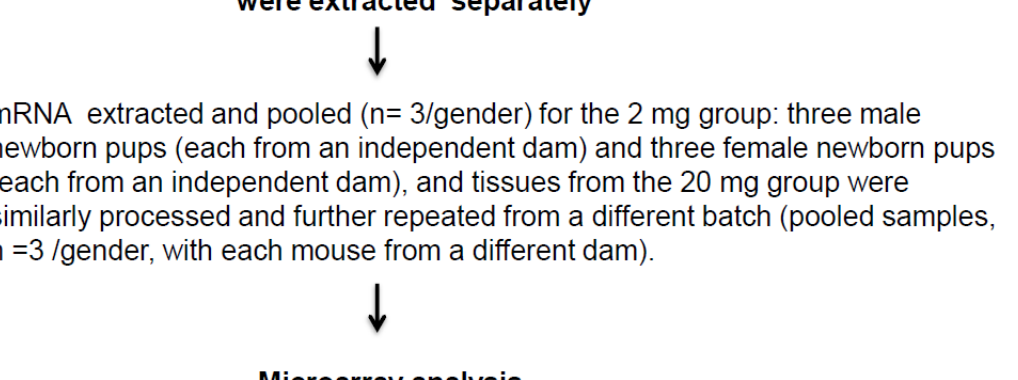
Figure 2. Schematic diagram of the study design illustrating main experimental